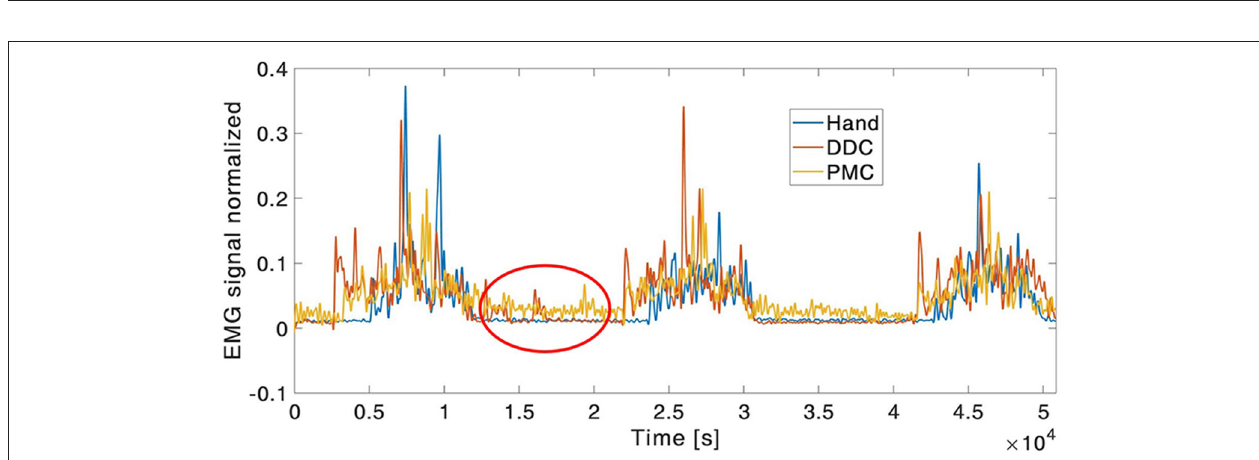
FIGURE 11 | Example of EMG envelope signal of the wrist flexor. In the red circle, it can be noticed the presence of muscle activity also during the relaxing period between trial during the execution with robotic